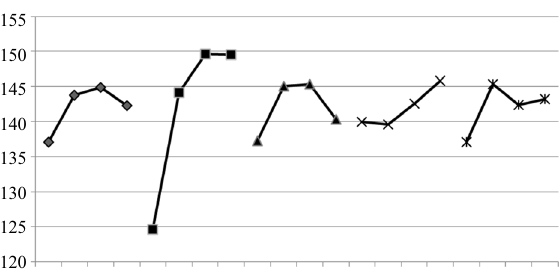
Fig. 4. The effect of factor levels